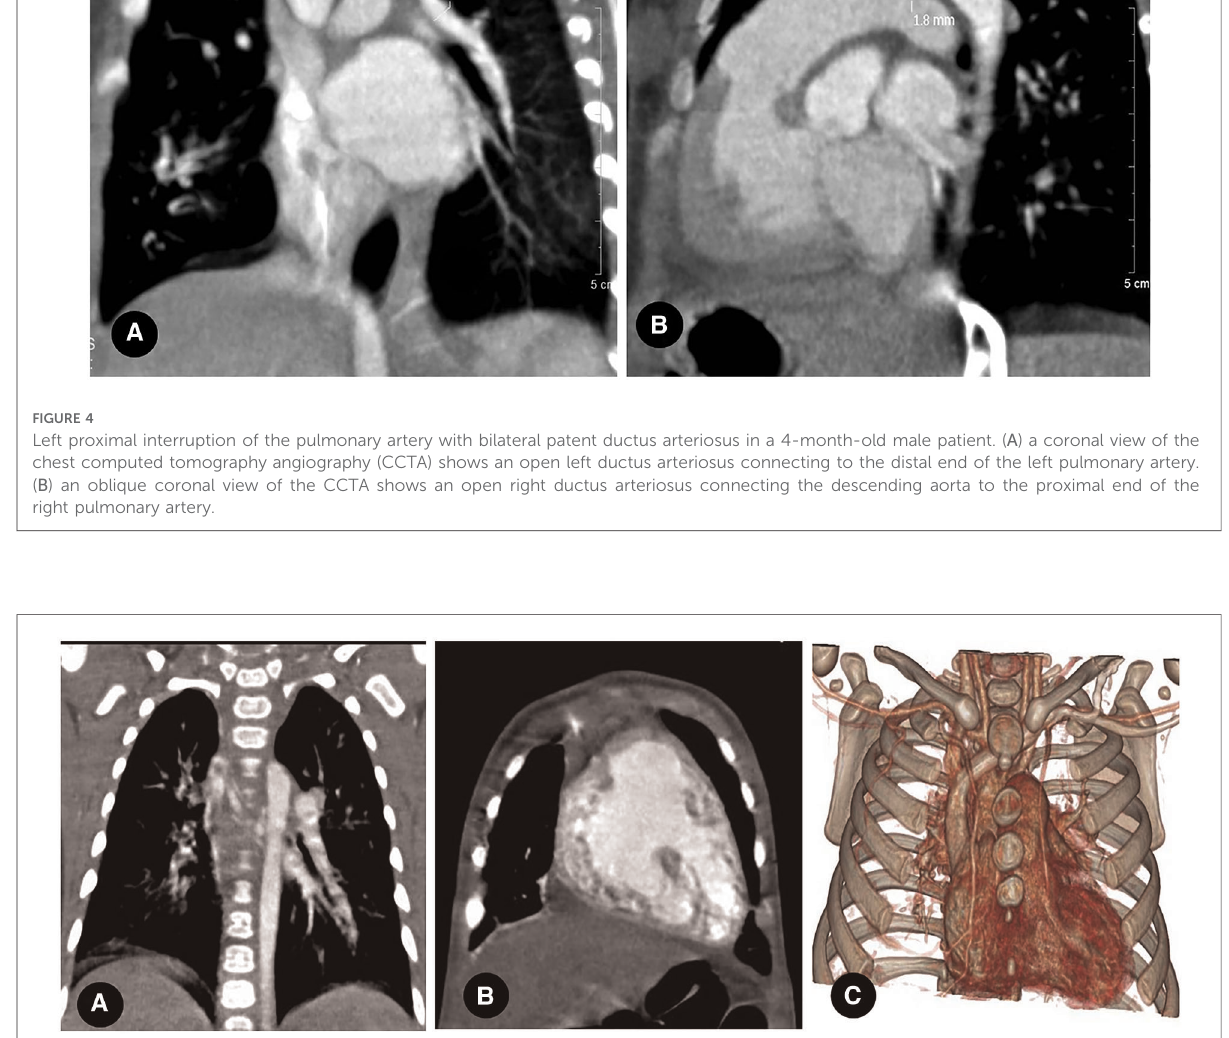
FIGURE 5 ( A ) right proximal interruption of the pulmonary artery (PIPA) in a 4-month-old male patient. A coronal view of the chest computed tomography angiography (CCTA) shows a dilated bronchial artery with small branches of the right internal pulmonary artery, a collateral circulation formed by the bronchial artery, and a right internal pulmonary artery segment. ( B ) right-sided PIPA in a 4-month-old male patient. A coronal view of the CCTA shows the dilation of the right inferior phrenic artery supplying blood to the right lower lung lobe through collateral arteries. ( C ) right- sided PIPA in a 4-month-old male patient. A virtual reality image shows the dilation and thickening of the right internal thoracic artery and the right subclavian artery and its